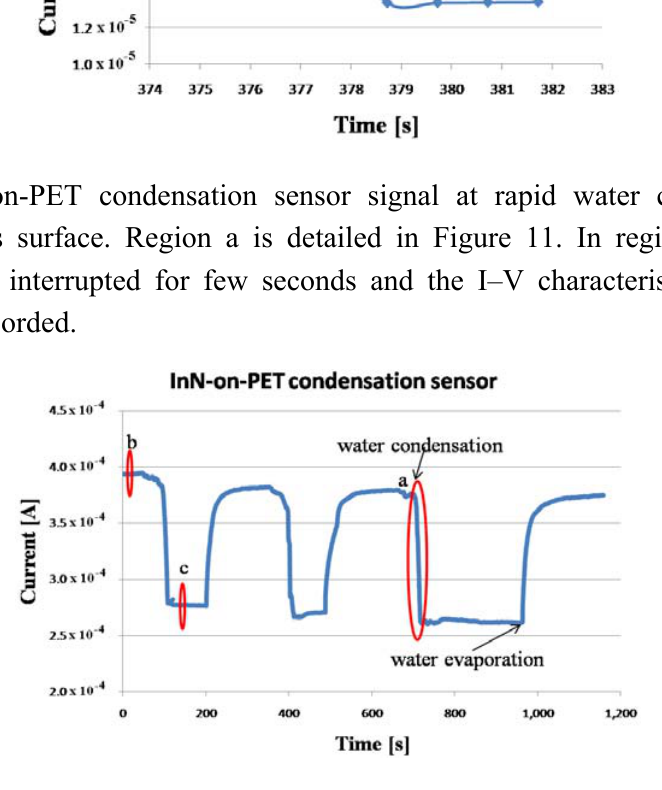
Figure 11. Current decrease during water condensation for an InN-on-PET condensation sensor. This corresponds to region a in Figure